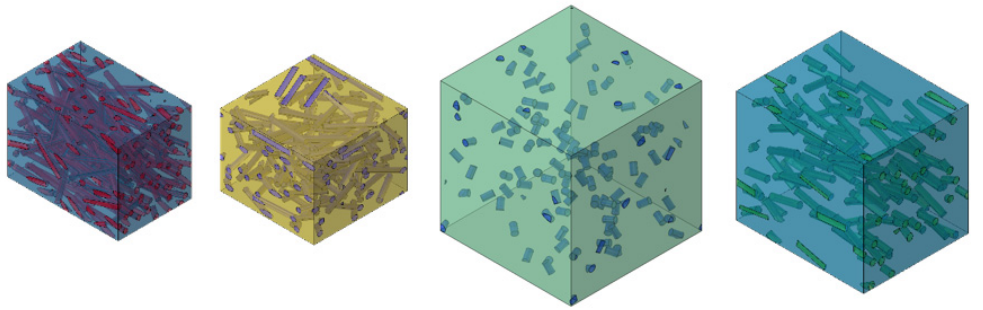
Figure 2. Illustration of four representative volume elements (RVEs) (each with 100 fibers) with different random parameters of the microstructure.